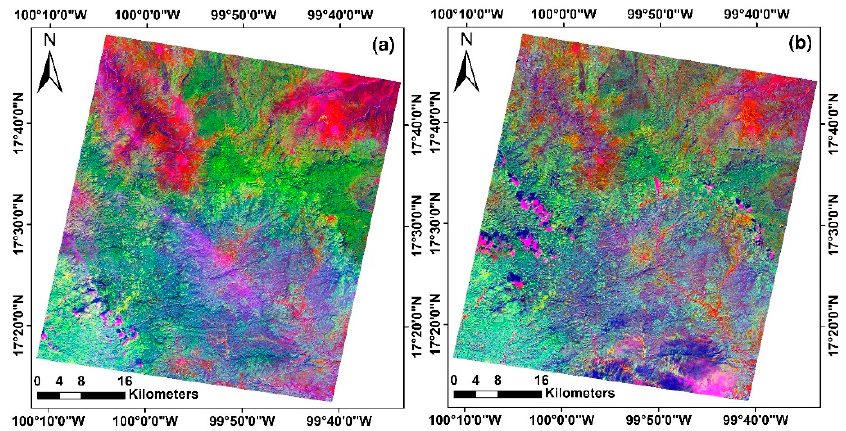
Figure 5. Principal Components (PC) images of ( a ) 10 December 2012, and ( b ) 13 December 2013.